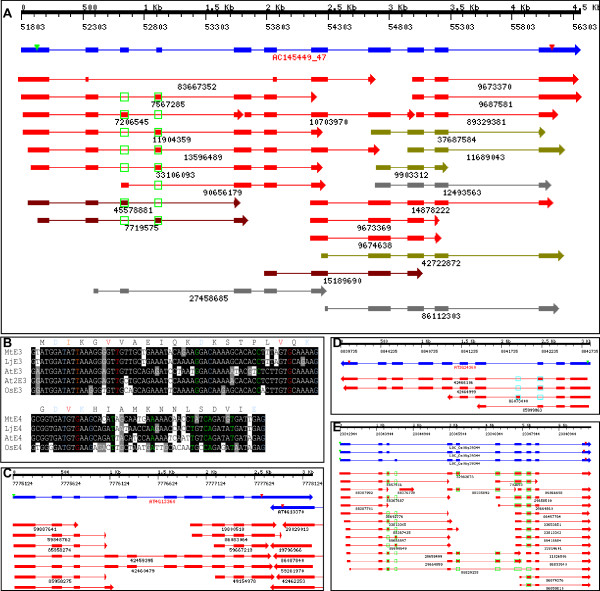
Completely conserved ExonS event in plant enoyl-CoA hydratase/isomerase genes. A: same-species and cross-species EST alignments in Mt gene locus AC145499_47. Filled boxes and arrows indicate exons, and lines indicate introns. Green open or filled boxes indicate exons skipped or retained in certain ESTs. The top black scale indicates coordinates for the gene locus on BAC (AC145499). The blue bar represents the IMGAG annotated gene model, with the green triangle representing the protein translation start codon and the red triangle representing the stop codon. Red bars represent individual same species EST alignments. Purple bars represent Lj ESTs, dark yellow bars represent soybean ESTs, and gray bars represent ESTs from other legume species. B. Multiple sequence alignments of the mutual exclusive exons. E3 indicates the Exon 3 and E4 indicates the Exon 4. At2E3 refers to the exon in the second copy of At gene (At4g13360). Amino acids encoded by Mt sequences are list at the top of sequence alignment. Degenerate positions (change in nucleotide will not change amino acids) which are conserved in all exons are highlighted in colors. C. EST alignment in the second copy of At gene (At4g13360). Only exon E3 exists in this gene and no ExonS can be detected. D, E. EST alignment in At and Os genes where the ExonS pattern is completely conserved.